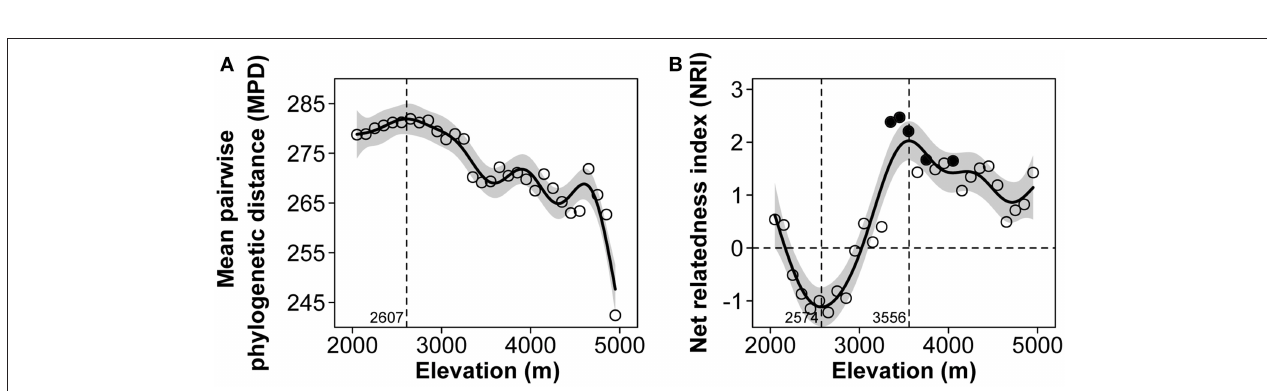
the spatial distribution of PD and FD and generating spatial mismatch between the structure of phylogeny and function (Losos, 2008; Prinzing et al., 2008; Devictor et al., 2010; Cachera